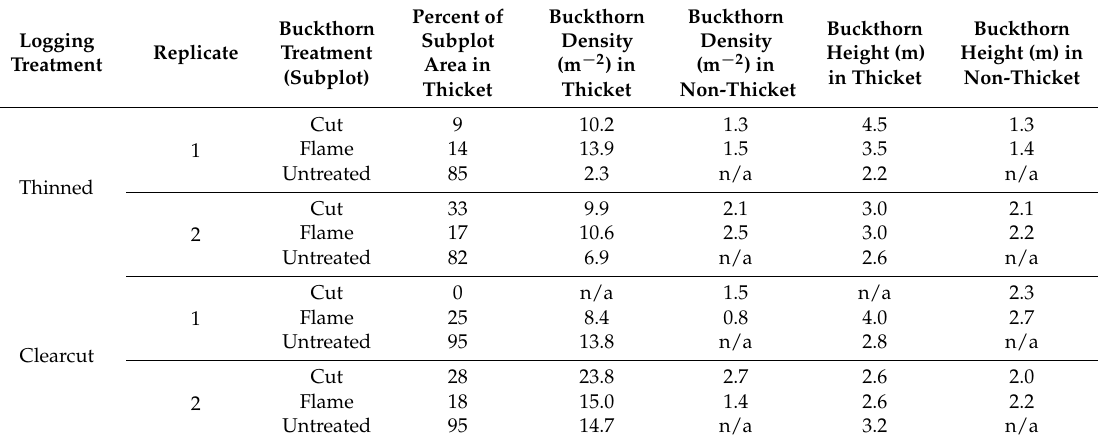
Table 1. Description of replicate plots in thinned and clearcut treatments. Percent cover of thicket habitat in each subplot. Mean density and height of buckthorn in thicket and non-thicket habitat in each subplot. Data collected at MacDonald Lot, Durham, NH, USA, in 2014.